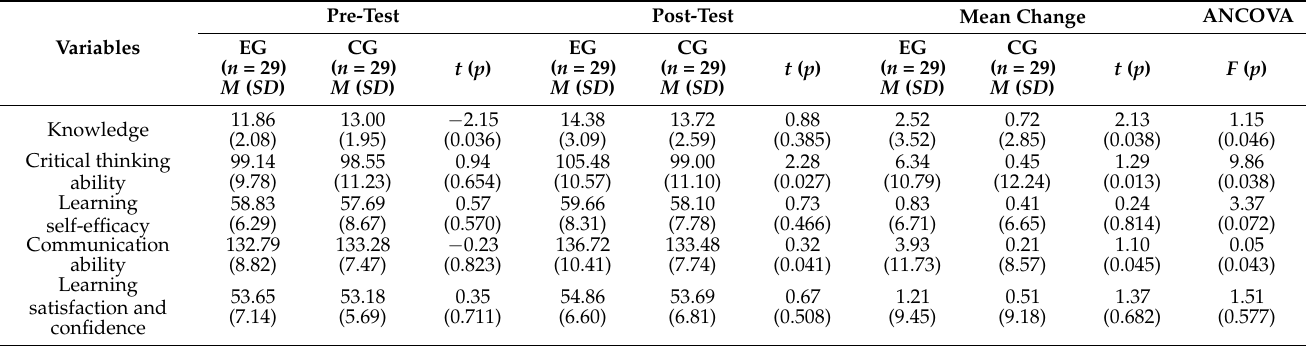
Table 4. Comparison of dependent variables among experimental and control groups ( n =